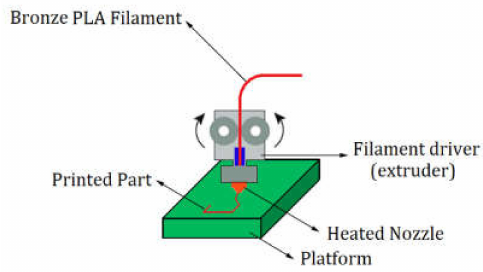
Figure 1. Schematic of 3D printing by the fused deposition modeling